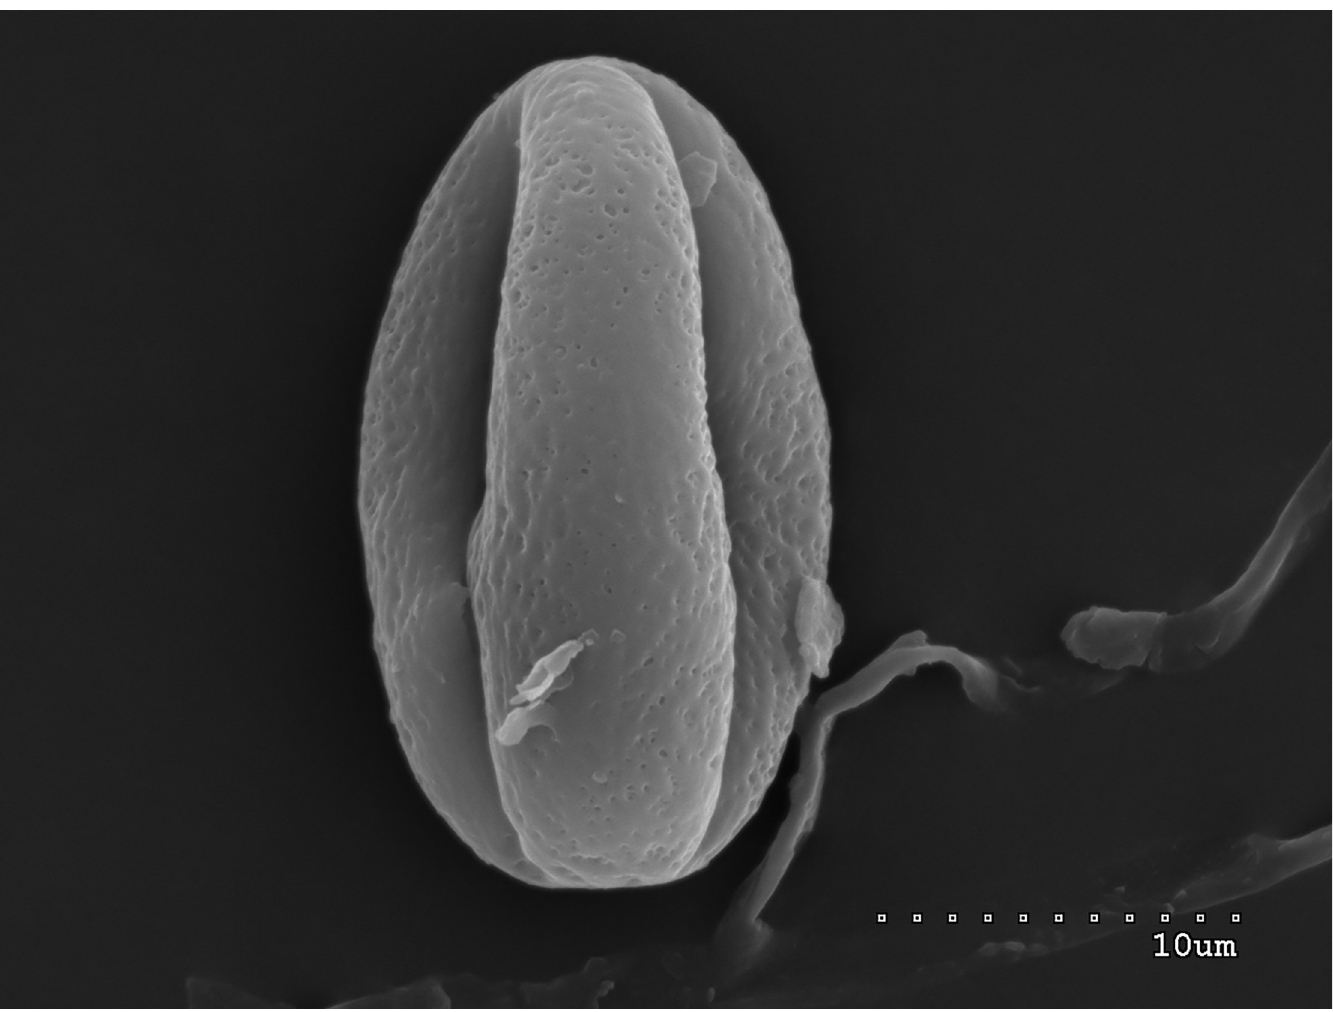
Fig 1. Pollen grain of S . tomentosa in equatorial view with two